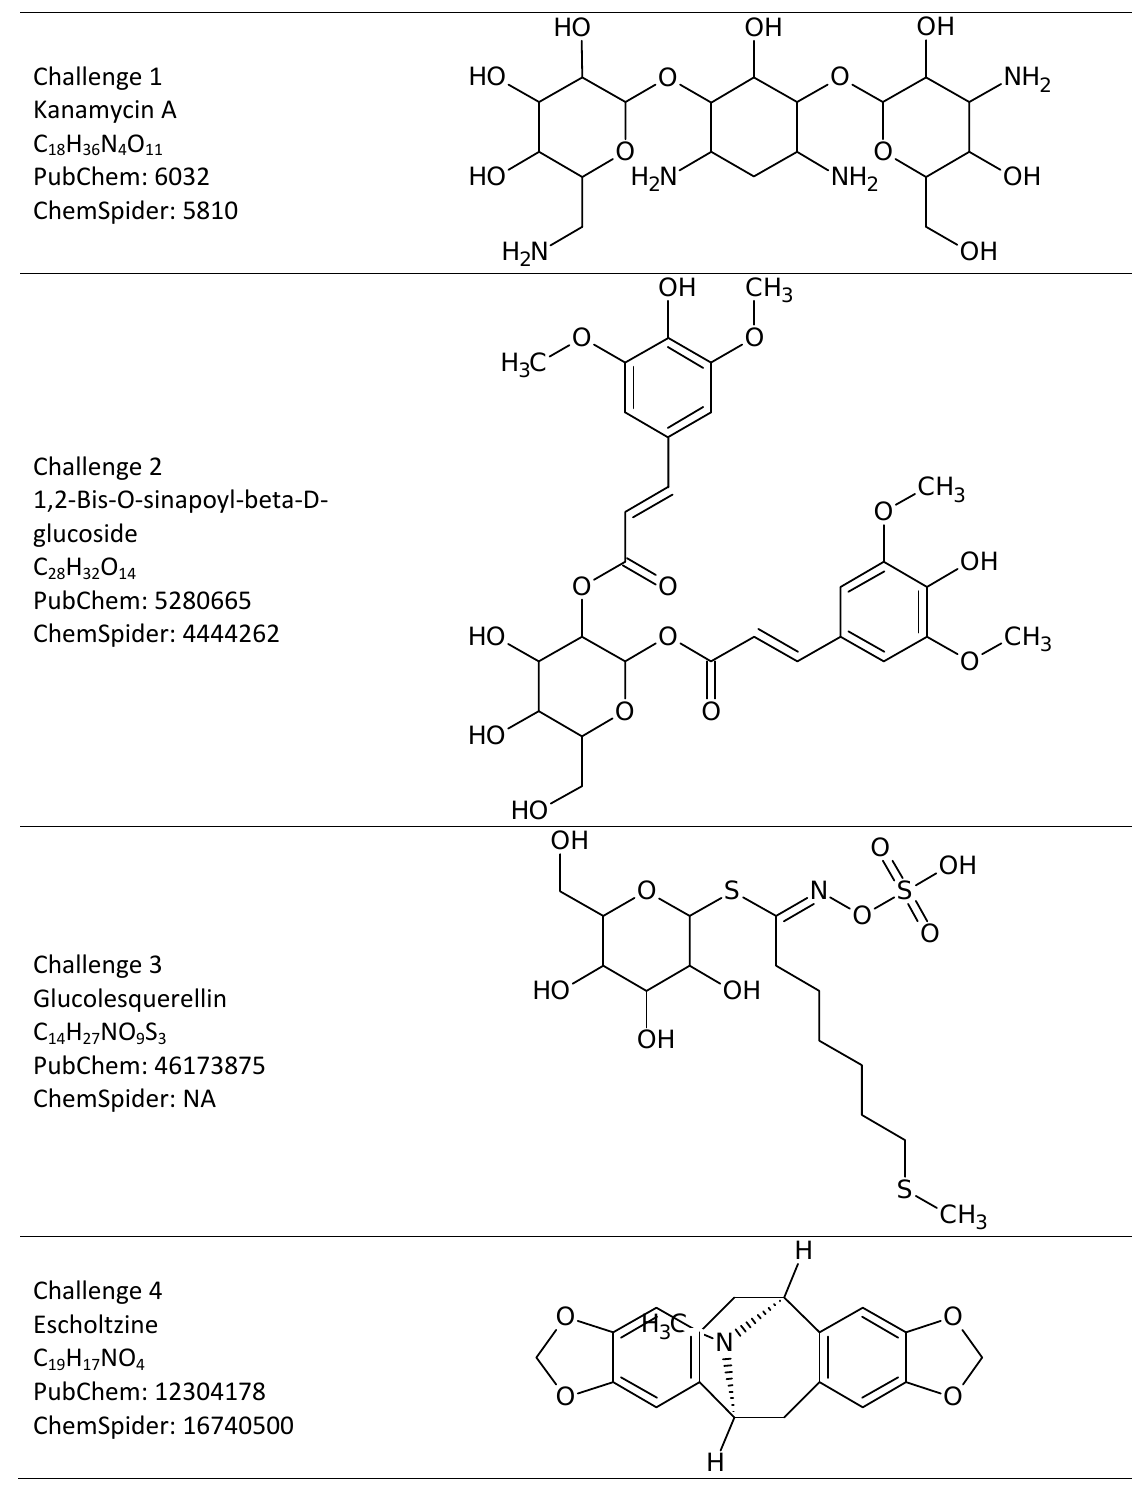
Figure B15. Structures and identifiers for LC-HRMS Challenges